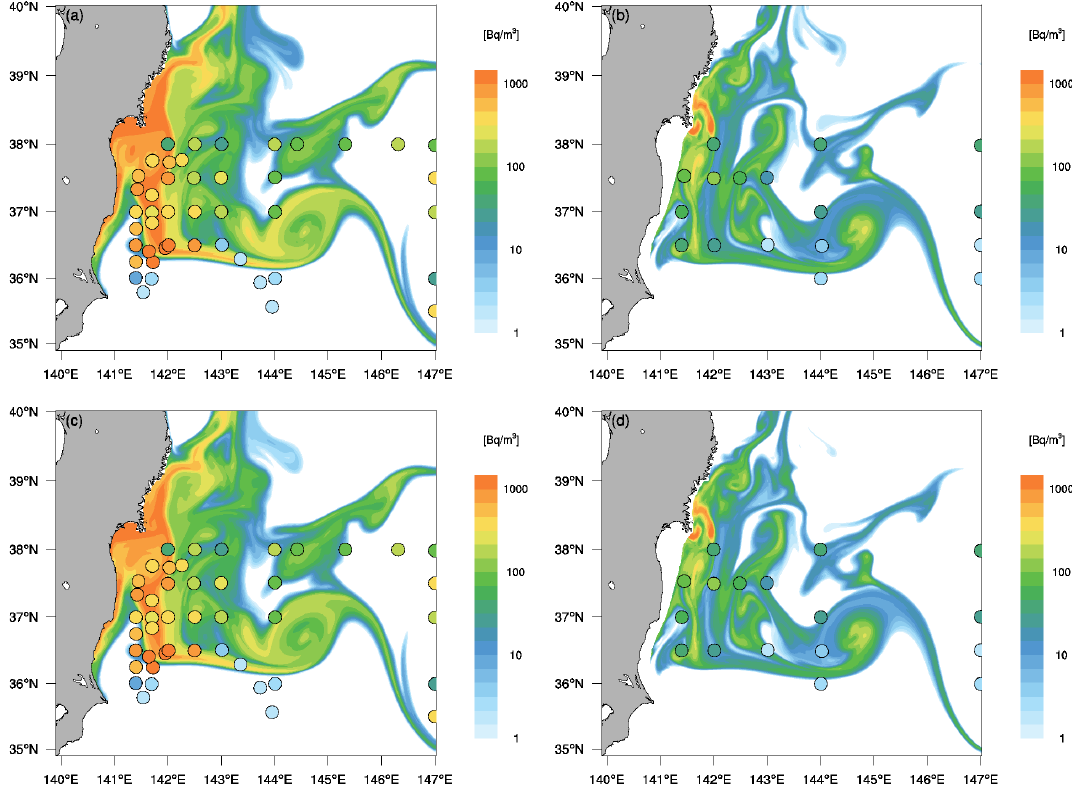
Fig. 9. 137 Cs activities (Bqm − 3 ) simulated in the NO INFLOW scenario on 15 June 2011 (a) in surface waters and (b) at a depth of 100m and measurements from 3–18 June 2011 (Buesseler et al., 2012). 137 Cs activities simulated in the D RELEASE scenario (c) in surface waters and (d) at a depth of